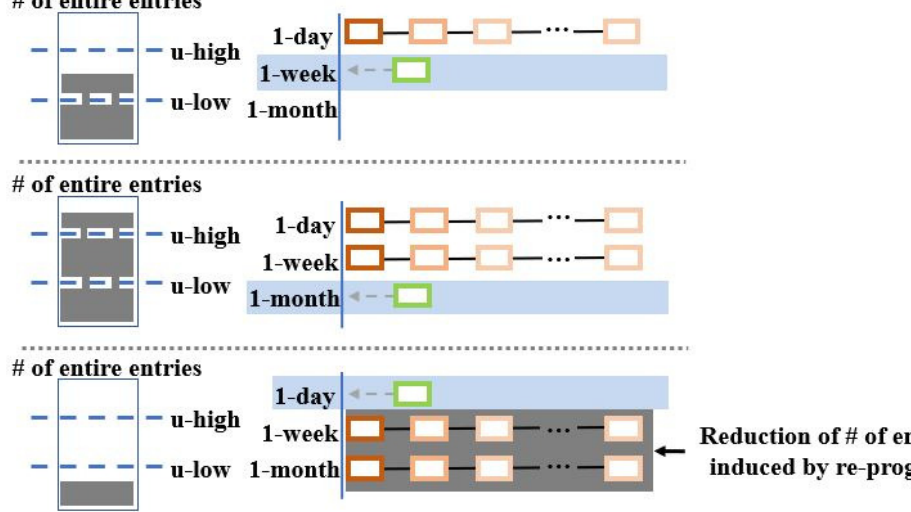
Figure 8. Optimized performance based on workload with dynamic write mode